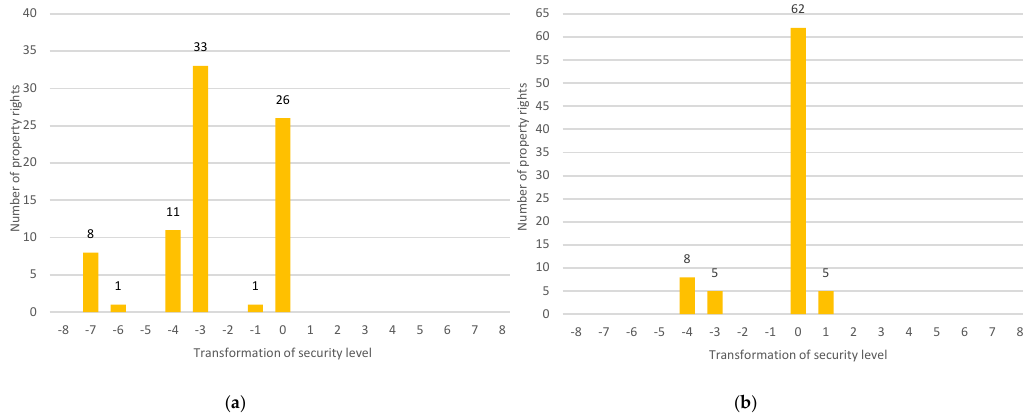
Figure 7. Transformation of the security level of property rights in KHI ( a ) cultivated and ( b ) residential lands.